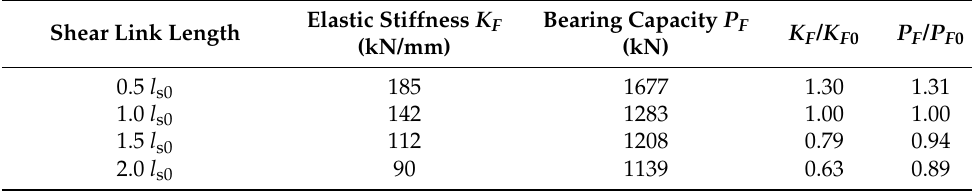
Table 5. Comparison of mechanical properties for different l s values.